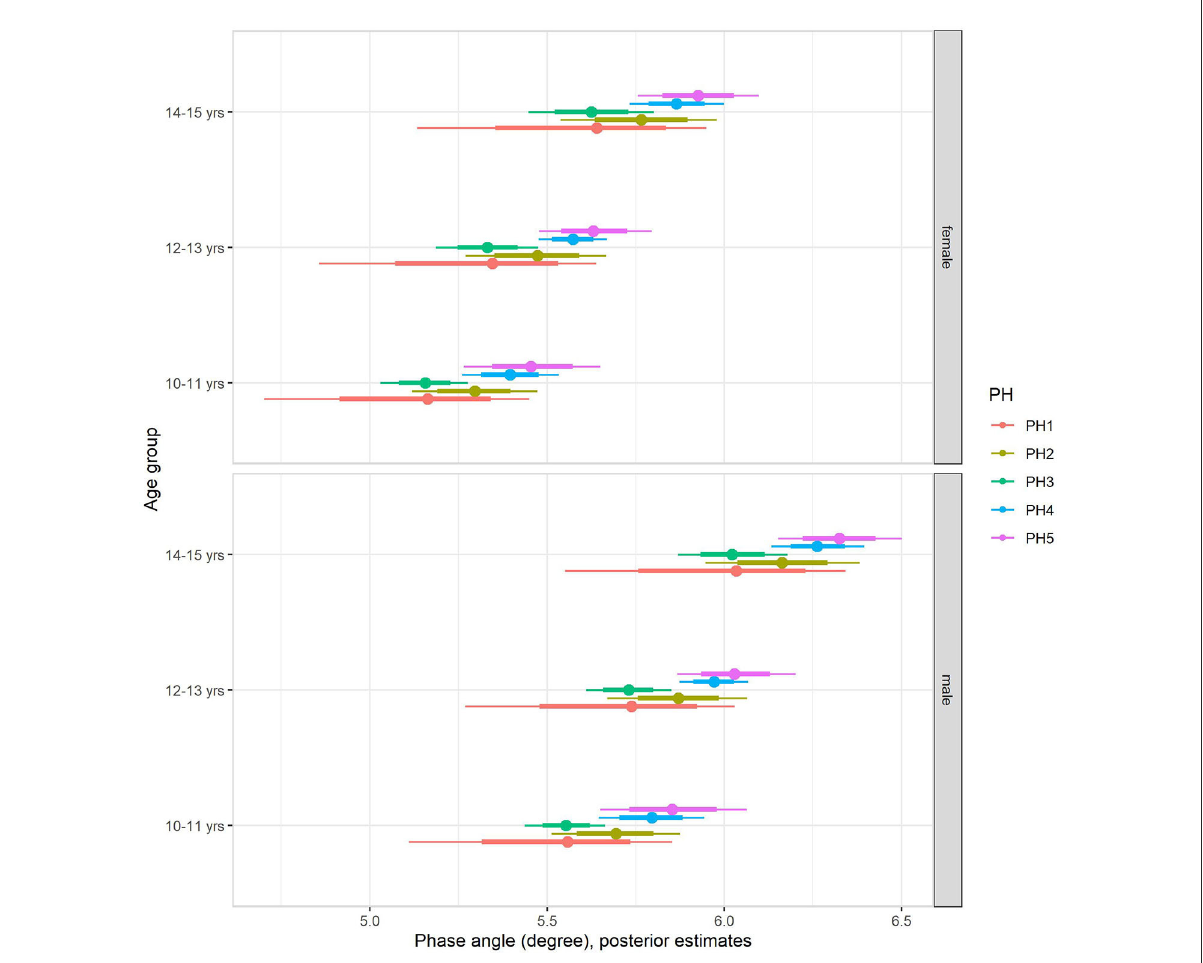
FIGURE1 Posterior estimations (67 and 90% CIs) for the phase angle by age group and sexual maturity among Brazilian girls and